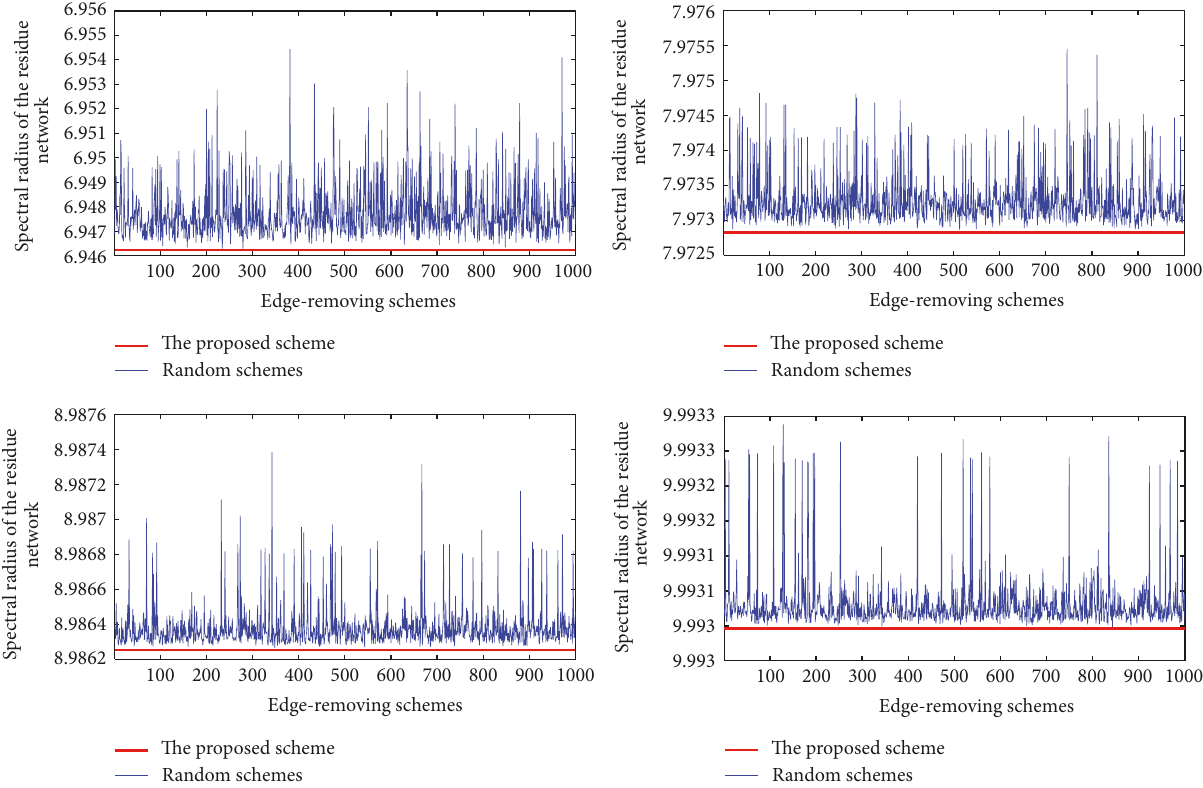
Figure 8: The proposed candidate (red) versus 10 3 random candidates